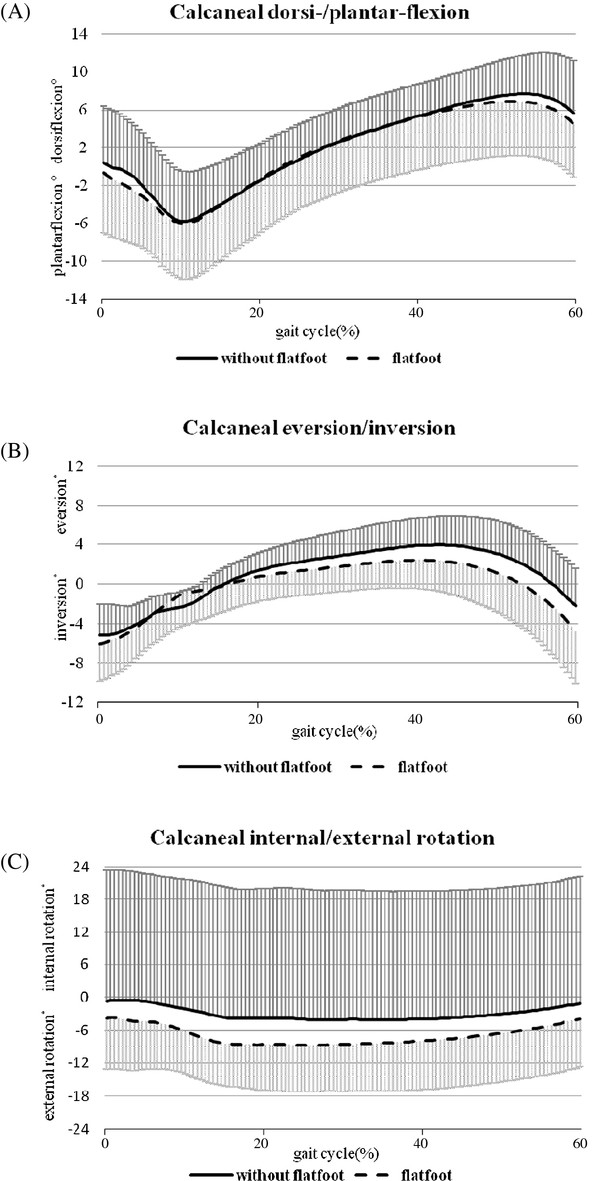
Movement pattern of ankle/foot complex. (A) Calcaneal dorsi-/plantarflexion, (B) eversion/inversion, and (C) internal/external rotation in children with (n = 20) and without (n = 10) flexible flatfoot during the stance phase (0-60% of the gait cycle) of comfortable walking. The standard deviations are shown in one direction.